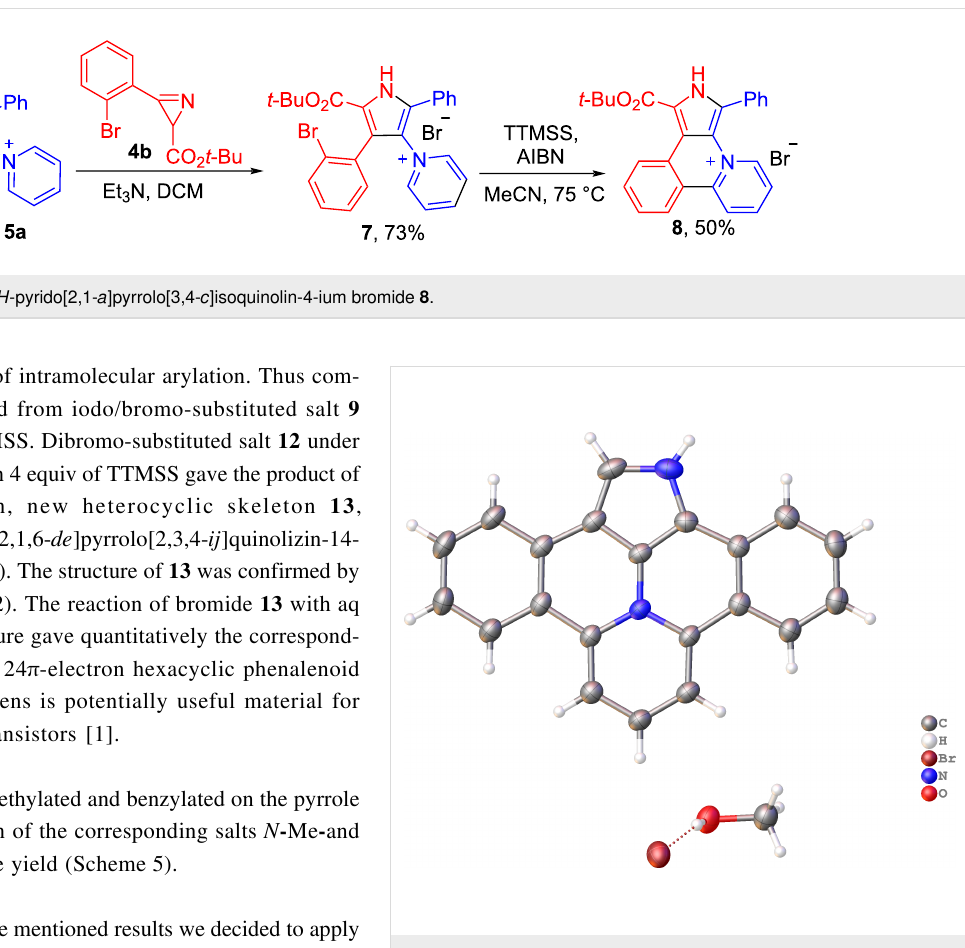
Figure 2: Molecular structure of compound 13 , displacement parame- ters are drawn at 50% probability